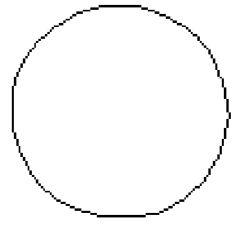
Figure 9. Contour of the tracked circular object in Figure 8.